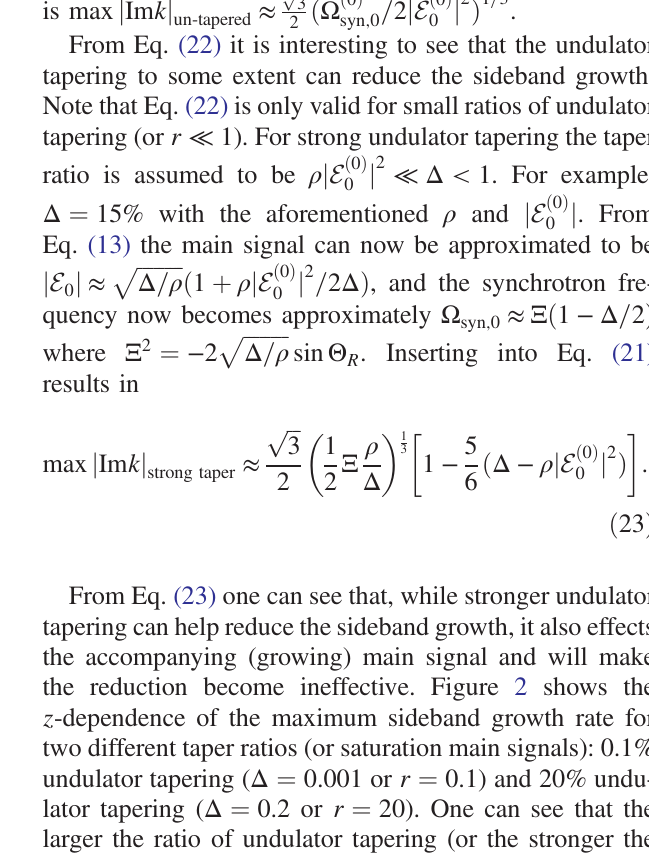
≈ 4 . 4 , j E j ≈ 10 , 0 syn ; 0